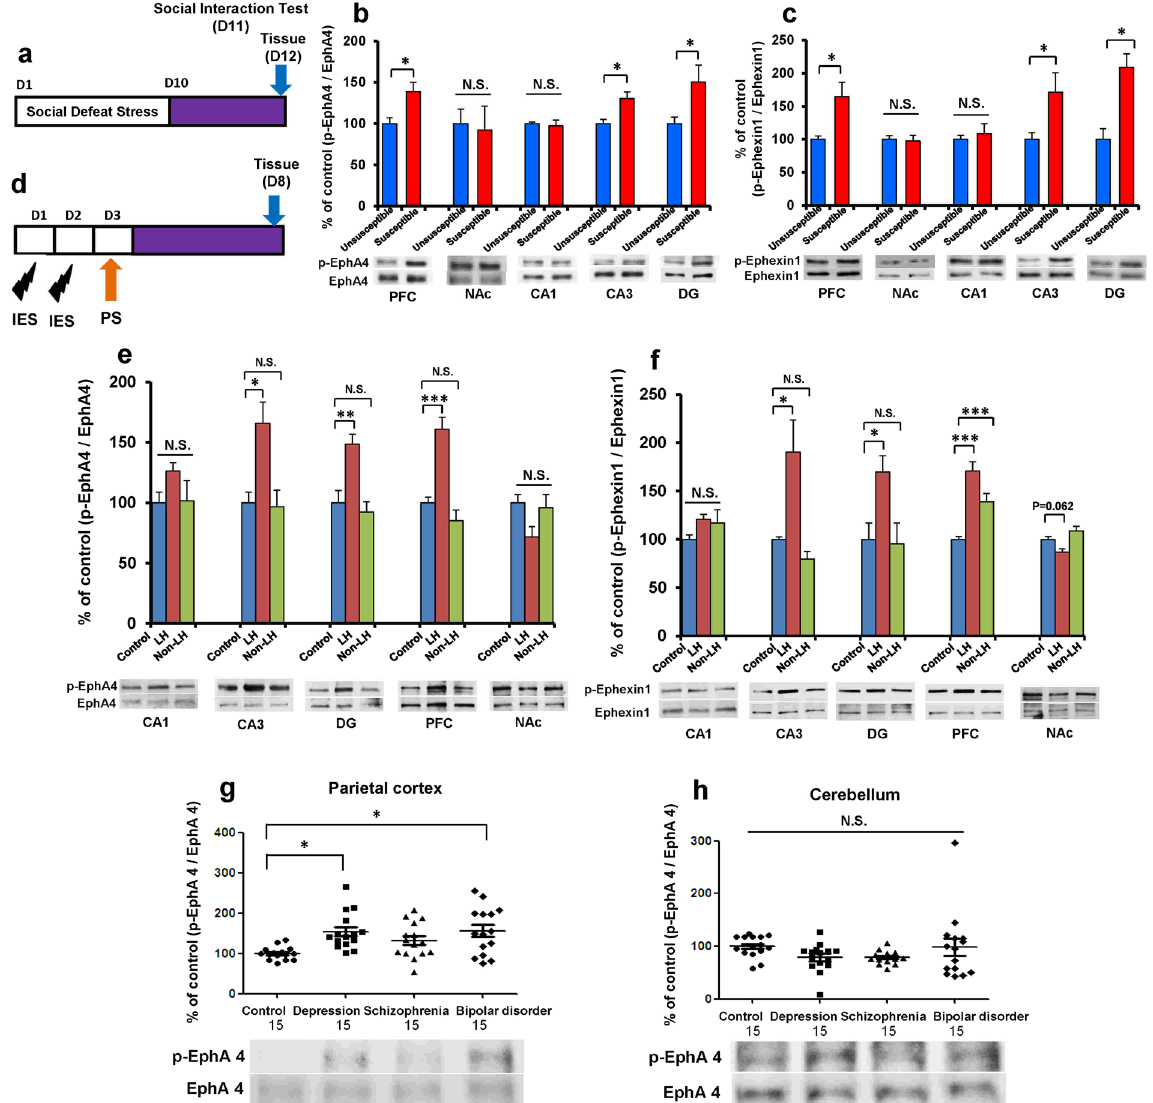
Figure 1. p-EphA4/EphA4 and p-ephexin1/ephexin1 ratios in the brain regions of mice with the depression- like phenotype and the postmortem brains of depressed patients. ( a ) Schedule of social defeat stress (10 days), social interaction test and brain sample collection. ( b and c ) The ratios of p-EphA4/EphA4 and p-ephexin1/ ephexin1 in the mouse brain regions from social defeat stress (susceptible) mice and control (unsusceptible) mice. Data represent the mean ± S.E.M. (n = 5 or 6). * P < 0.05 compared with the control group. N.S.: not significant (Student’s t -test). ( d ) Schedule of learned helplessness (LH) and brain sample collection. ( e and f ) The ratios of p-EphA4/EphA4 and p-Ephexin1/Ephexin1 in the rat brain regions from control, LH, and non-LH rats (n = 5–6). Data represent the mean ± S.E.M. * P < 0.05, ** P < 0.01 and *** P < 0.01 compared with the control group. N.S.: not significant. ( g and h ): The ratios of p-EphA4/EphA4 in the postmortem brain samples (parietal cortex and cerebellum) from control, depression, schizophrenia, and bipolar disorder subjects. Data represent the mean ± S.E.M. (n = 15). * P < 0.05 compared with control group, N.S.: not